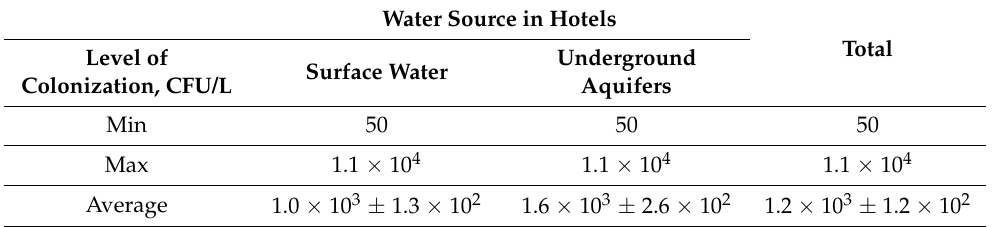
Table 2. L. pneumophila colonization level (CFU/L) in hotels supplied from different water sources.